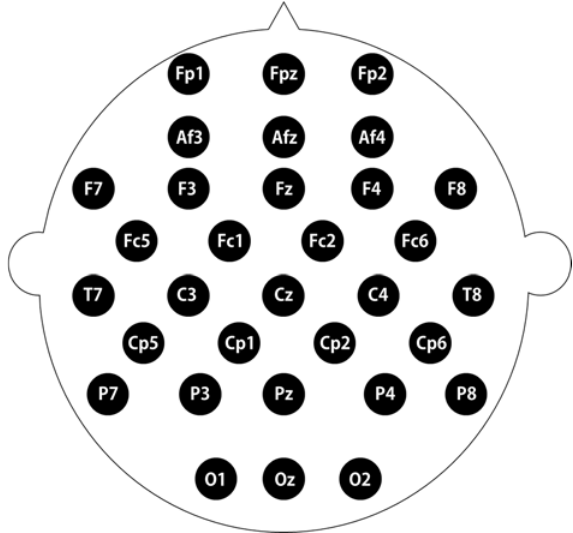
Figure 1. The electrode placement sites according to the International 10–20 system, with modified combinatorial nomenclature. combinatorial